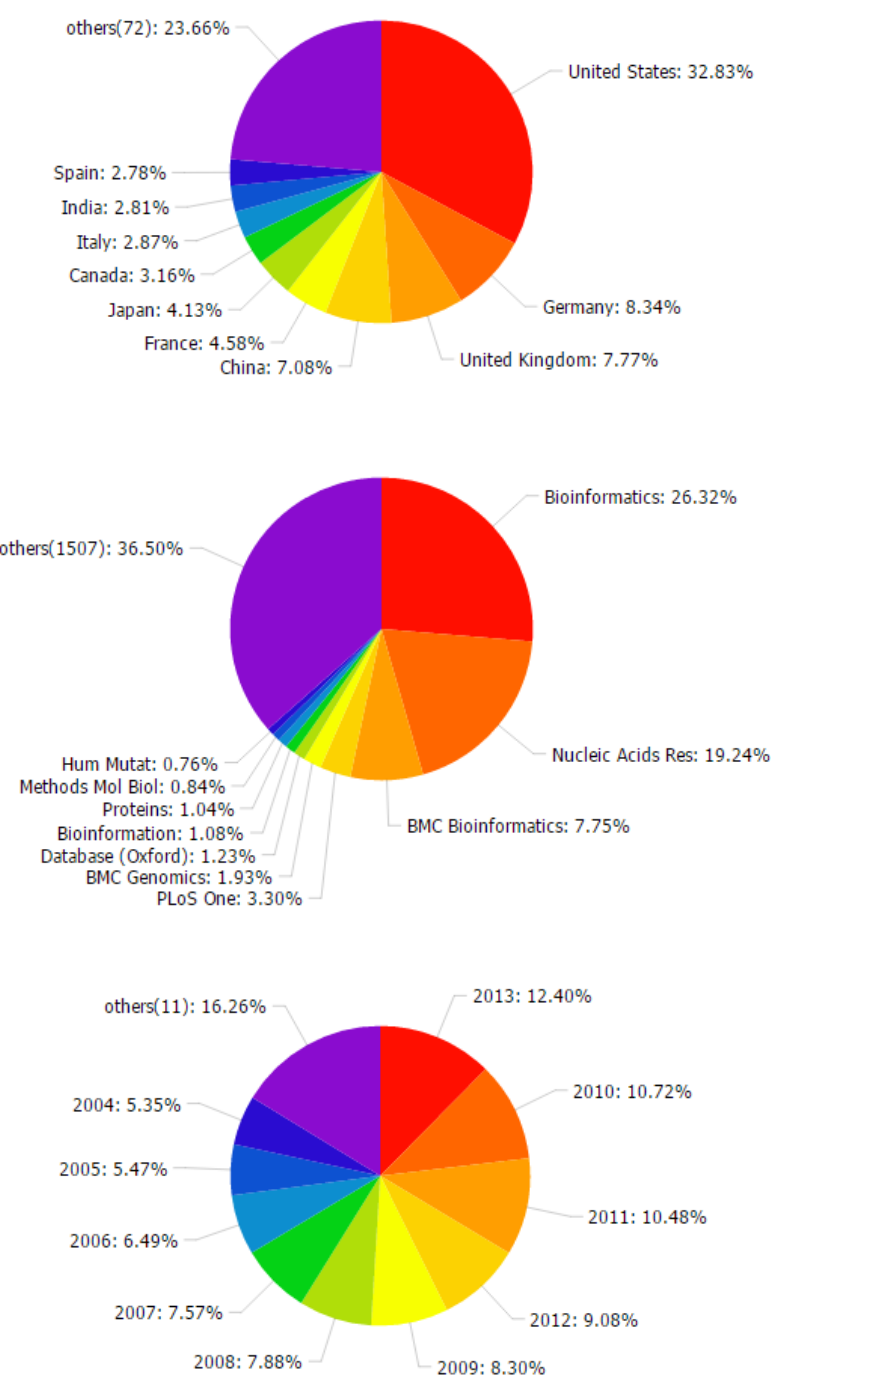
Figure 3: DaTo status statistics of countries (A/top), journals (B/center) and years